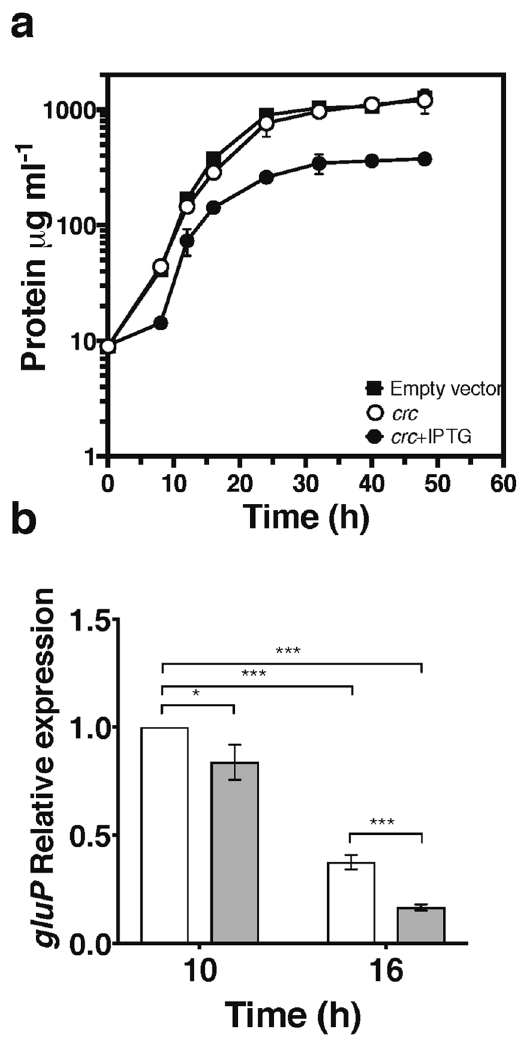
Figure 5. Crc over-expression diminishes growth on glucose. ( a ) Growth kinetics of the wild type A . vinelandii AEIV strain, harbouring the empty vector pSRK-Km ( ■ ) or the pSRK-crc ( crc + ) vector, in the presence ( ● ) or absence ( ○ ) of 1 mM IPTG. Cultures were developed in Burk’s minimal medium supplemented with 30 mM glucose (BG) as the sole carbon source and 1.5 µ gml − 1 of kanamycin as a selection marker. 25 ml of Burk’s medium supplemented with 30 mM sucrose were cultured for 18 h; cells were harvested by centrifugation, washed with phosphate buffer 10 mM pH 7.2 and resuspended in the same solution. 400 µ g of these cells were used to inoculate 50 ml of BG medium and samples were collected at the indicated times for protein quantification. Cell growth was estimated by determining protein concentration since the production of the exo-polysaccharide alginate by the AEIV strain prevents assessment of growth by optical density. The results represent the averages of the results of three independent experiments, and error bars depict standard deviations. ( b ) Relative expression levels of gluP mRNA, quantitated by qRT-PCR analysis, in cells of the wild type AEIV strain carrying the vector pSRK-crc in the absence (white colums) or presence (grey columns) of 1 mM IPTG. The growth conditions were as in panel ( a ). Total RNA was extracted from cells at the indicated times. The bars of standard deviation from three independent experiments are shown. Significant differences were analysed by t -test. Statistical significance is indicated ( * p < 0.05 or *** p <